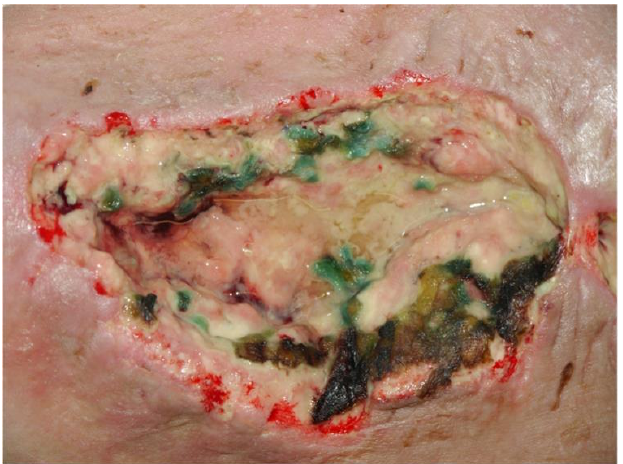
Figure 2. Wound colonized with Pseudomonas aeruginosa .